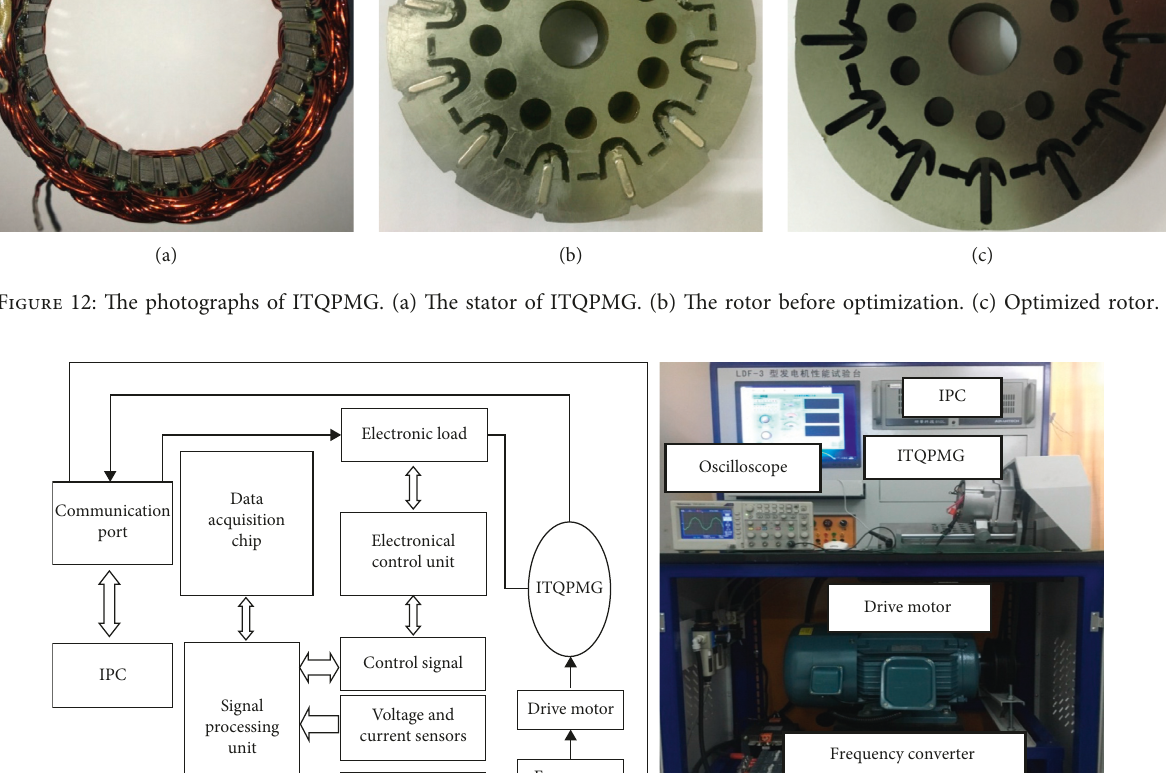
Figure 13: Generator performance test system and its principle block